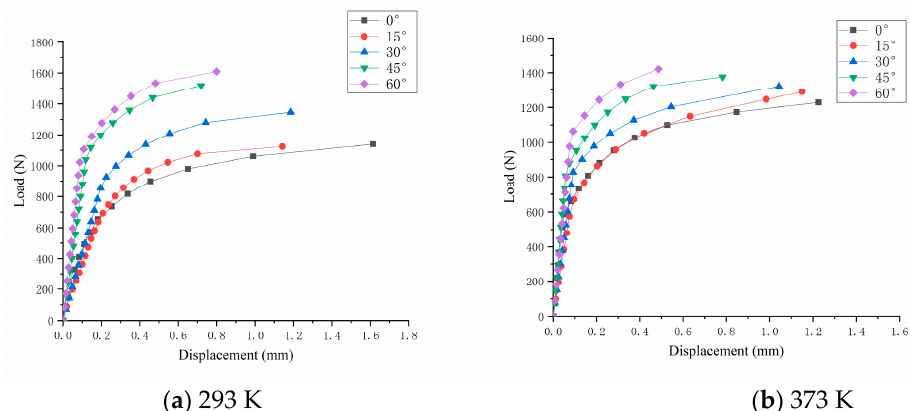
Figure 5. Partial shear specimen test diagram.